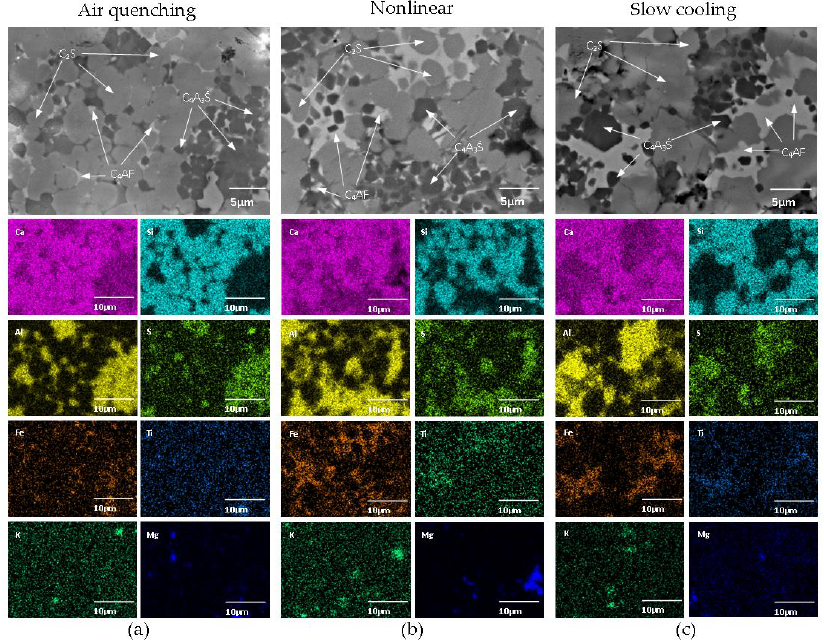
Figure 4. SEM-BSE images and the corresponding energy dispersive X-ray spectrometer (EDS) elemental mapping of the clinkers with main clinker phases marked (C 2 S = belite, C 4 A 3 Ś = calcium sulfoaluminate, C 4 AF = ferrite) for air quenched clinker ( a ), nonlinearly cooled clinker ( b ), and slowly cooled clinker ( c ).